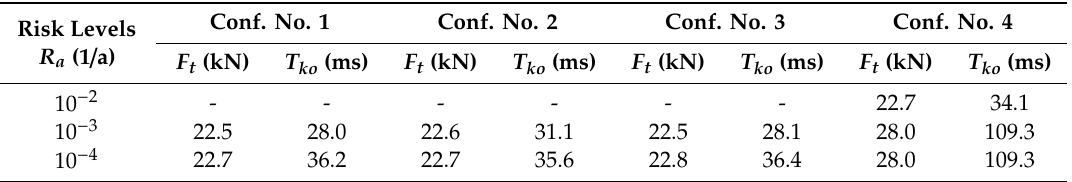
Table 5. Values of force F t and time T ko for defined risk levels and di ff erent PSPA configurations under short circuit conditions at lookout point B.